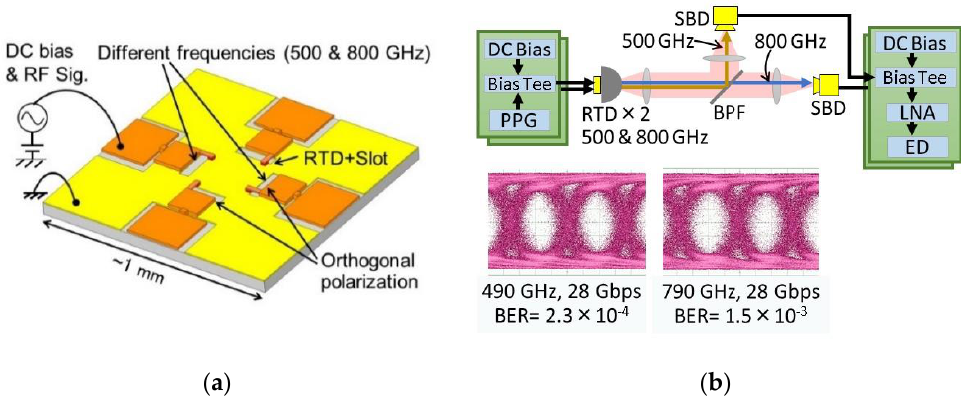
Figure 12. RTD oscillators with different frequencies and polarizations integrated into one chip for wireless transmission with frequency and polarization multiplexing. Copyright (2017) IEEE. Reprinted with permission from [40]: ( a ) Schematic structure of the integrated chip, and ( b ) diagram of the transmission with frequency multiplexing and the resulting